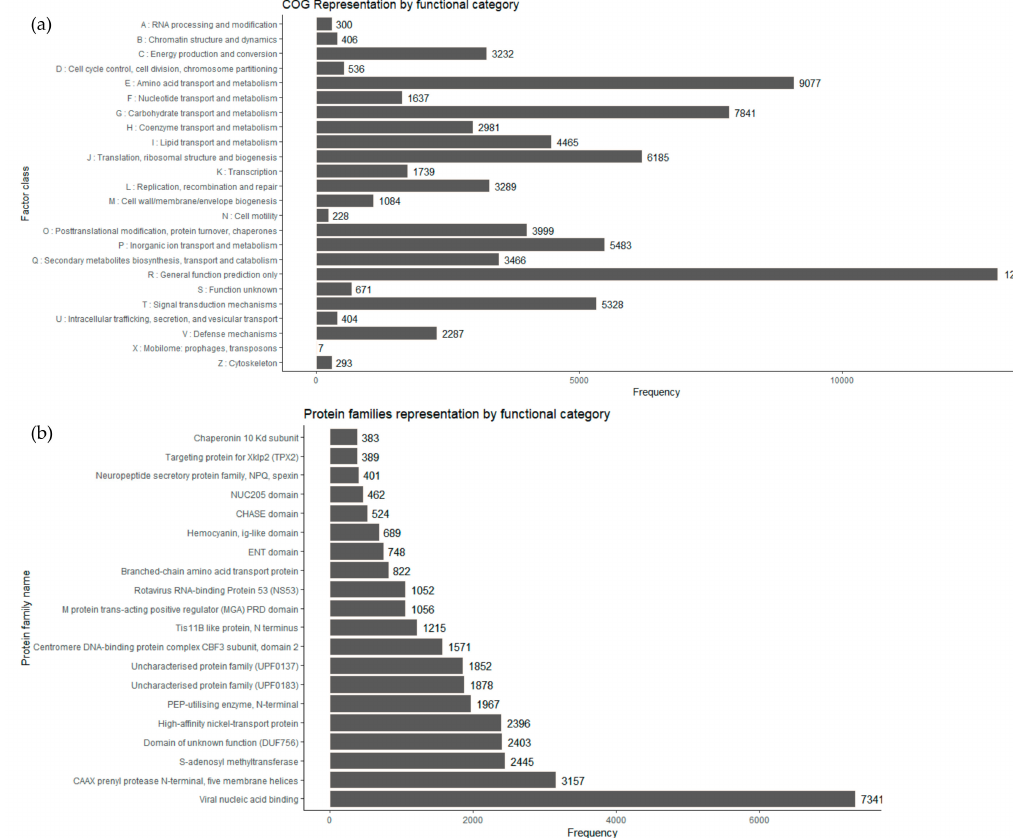
Figure 5. Annotation of the Inonotus obliquus transcriptome. ( a ) Cluster of orthologous groups (COG). ( b ) Protein family database (Pfam) classification of transcripts from Inonotus